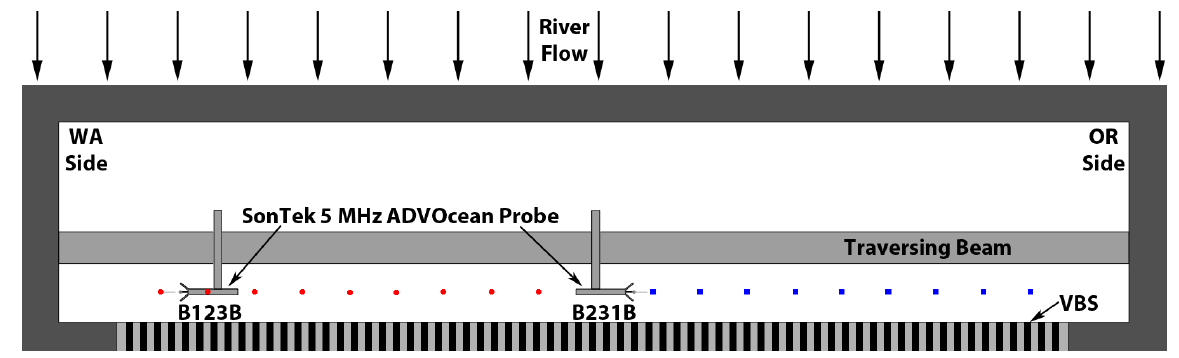
Figure 4. Acoustic Doppler velocimeter probe schematic for measurements taken 0.2 m from the vertical barrier